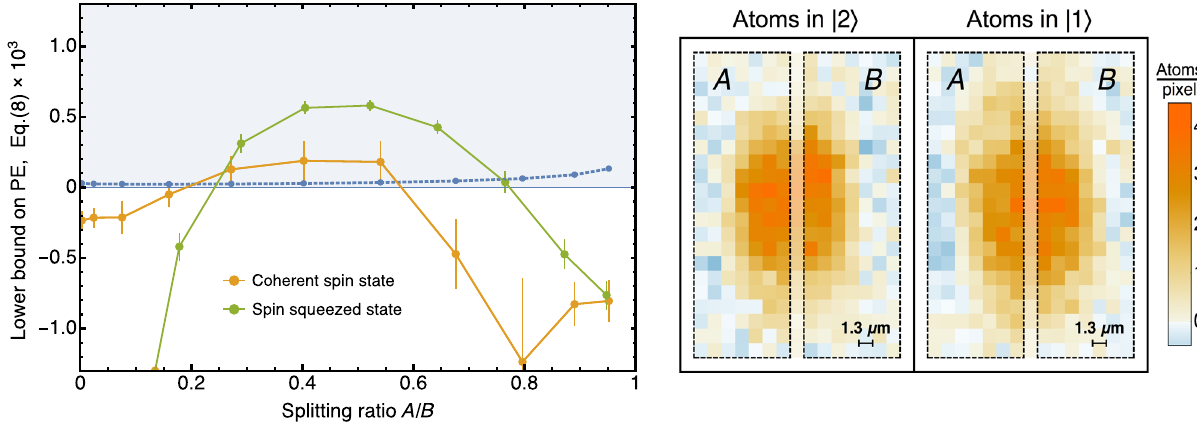
FIG. 2. Based on the measurements [61] we are able to extract the lower bound given by the right-hand side of Eq. (15) on the PE measure M Tr . The two sets of points correspond to initializing the BEC either in a spin-squeezed state (green), where particle PE entanglement is present, or in a coherent spin state (orange), which is particle separable. Along the horizontal axis we vary the relative size of the two regions A and B from which we extract the spin values as explained in Ref. [61]. In the experiment, technical limitations in the resolution of assigning the atomic spins to the regions can lead to classical correlations, resulting in apparent entanglement. We give an upper bound for these correlations as the blue dashed line. For intermediate splitting ratios we find significant entanglement in the case of the spin-squeezed state while the coherent spin state remains compatible with no particle entanglement within experimental error. On the right we show single-shot absorption images of the atomic densities for the two internal degrees of freedom, with an ˆ ˆ S A and S B entering in Eq. example of regions A and B used to define the collective spins